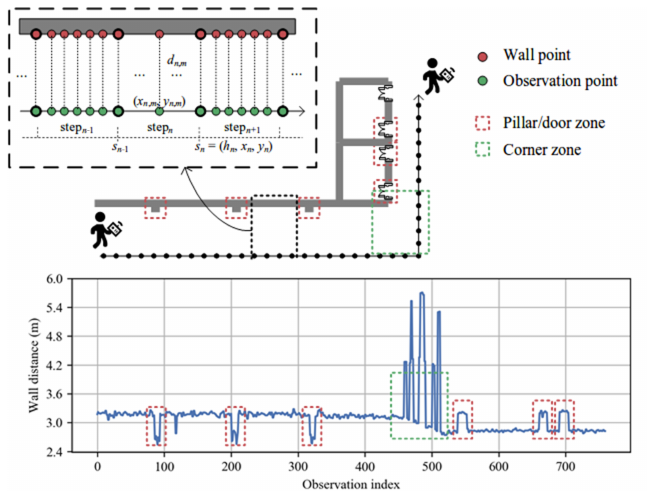
Figure 2. Problem description. The user trajectory is represented by a sequence of pedestrian poses. Each pose s n is denoted as a tuple ( h n , x n , y n ) with h n the heading orientation and ( x n , y n ) the step coordinate. The wall distance between adjacent steps establishes the positional relationship between pedestrian pose and the surrounding walls. Each wall distance d n , m links an observation point on the trajectory and a wall point on the wall surface. The wall distance observations suffer from large fluctuations due to corner and barrier (e.g., pillar or door) zones on the